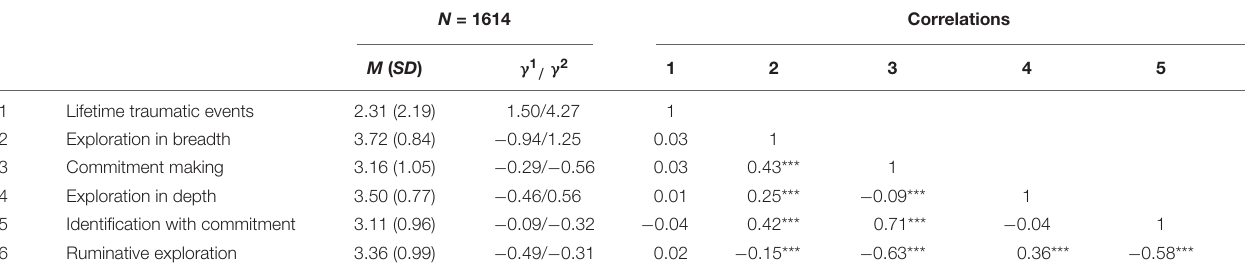
TABLE 2 | Descriptive statistics and correlations of study variables.